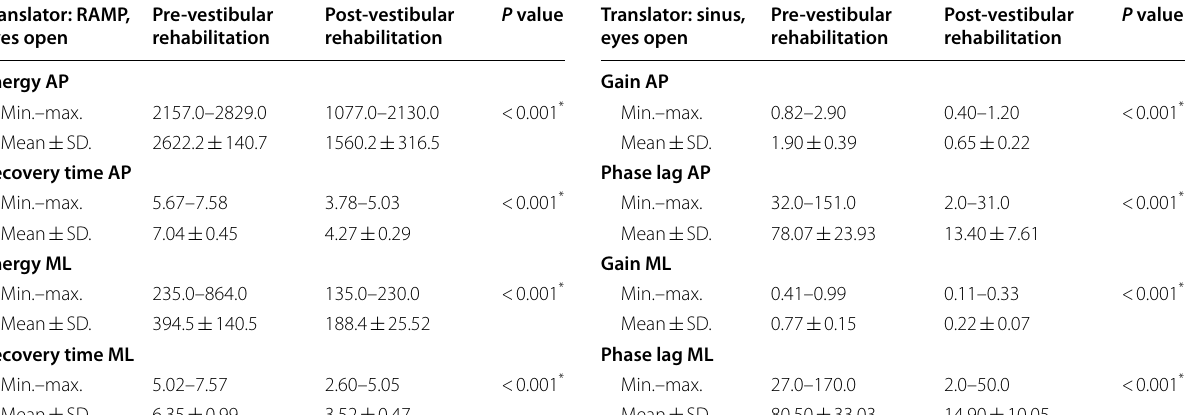
Table 14 Comparison of translator: sinus eyes open before